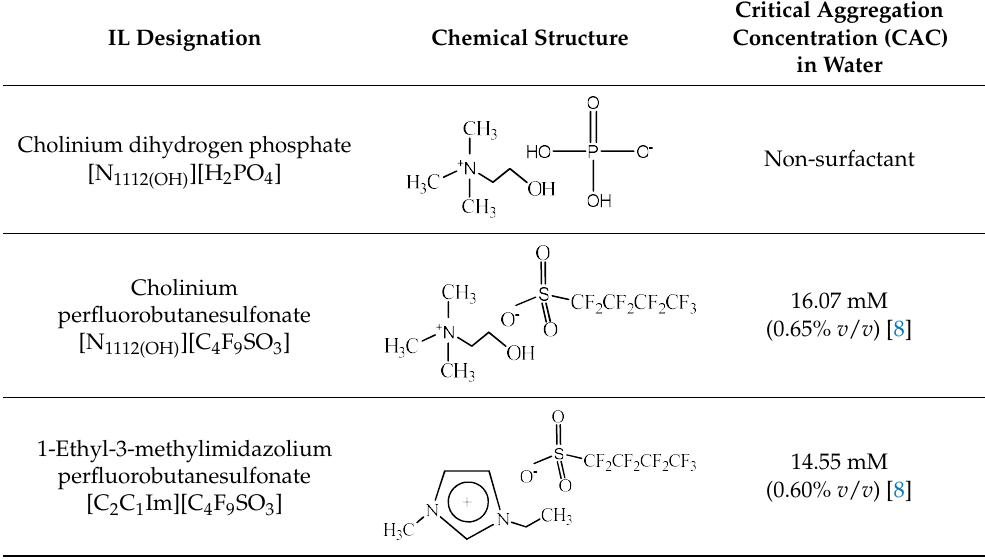
Table 1. Chemical structures and acronyms of the ionic liquids (ILs) used in this work.